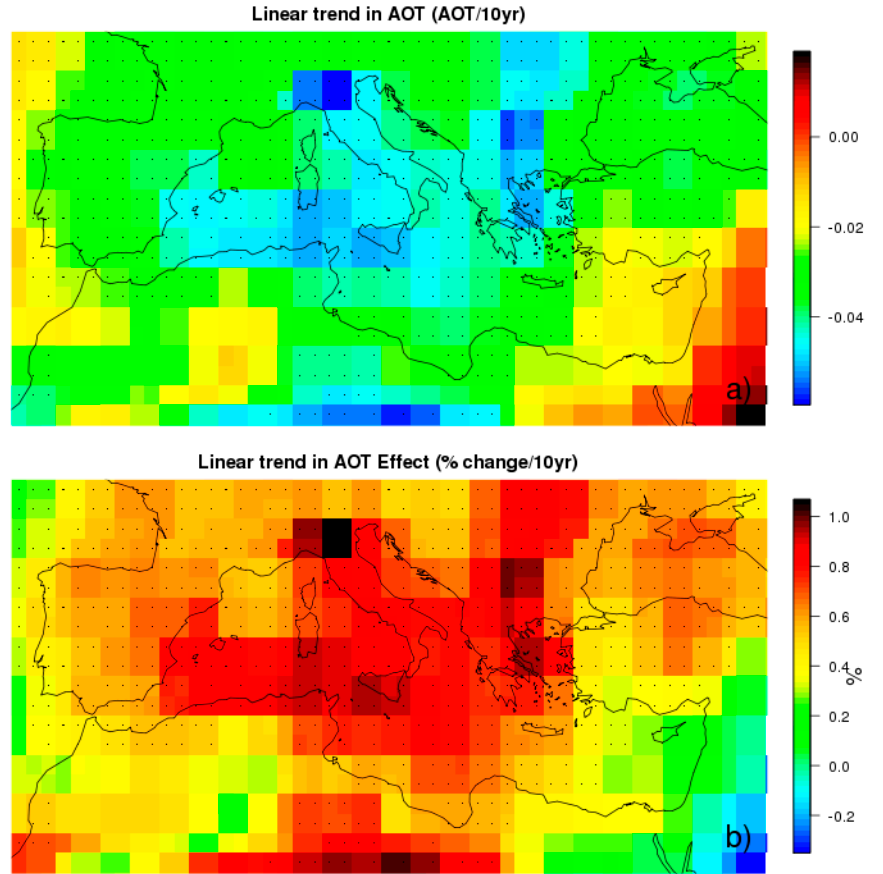
Figure 8. Spatial distribution of linear trend in (a) AOT and (b) AOT effect, for 2000–2018 per decade. Pixels with levels of significance p <0.05 are marked with a black dot.